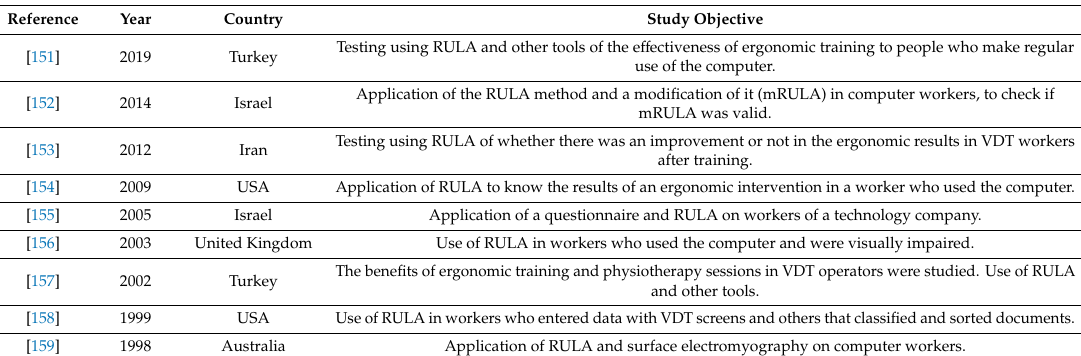
Table 11. Information and